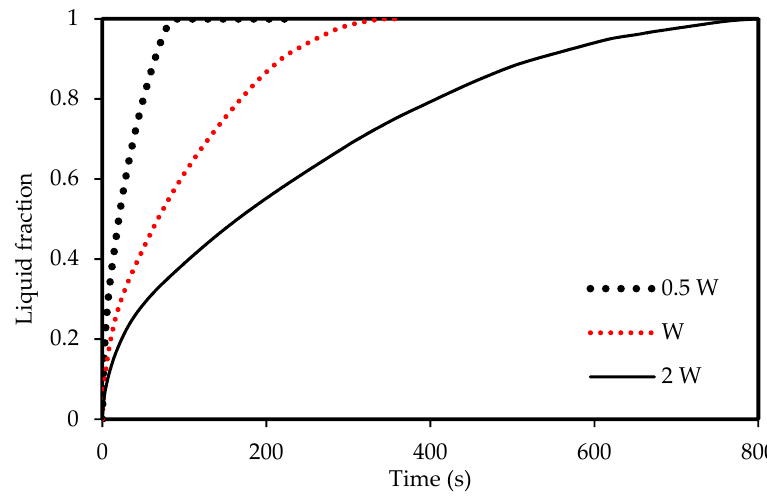
Figure 12. Evolution of the liquid-fraction for the melting process in the horizontal corrugated channel for different widths.